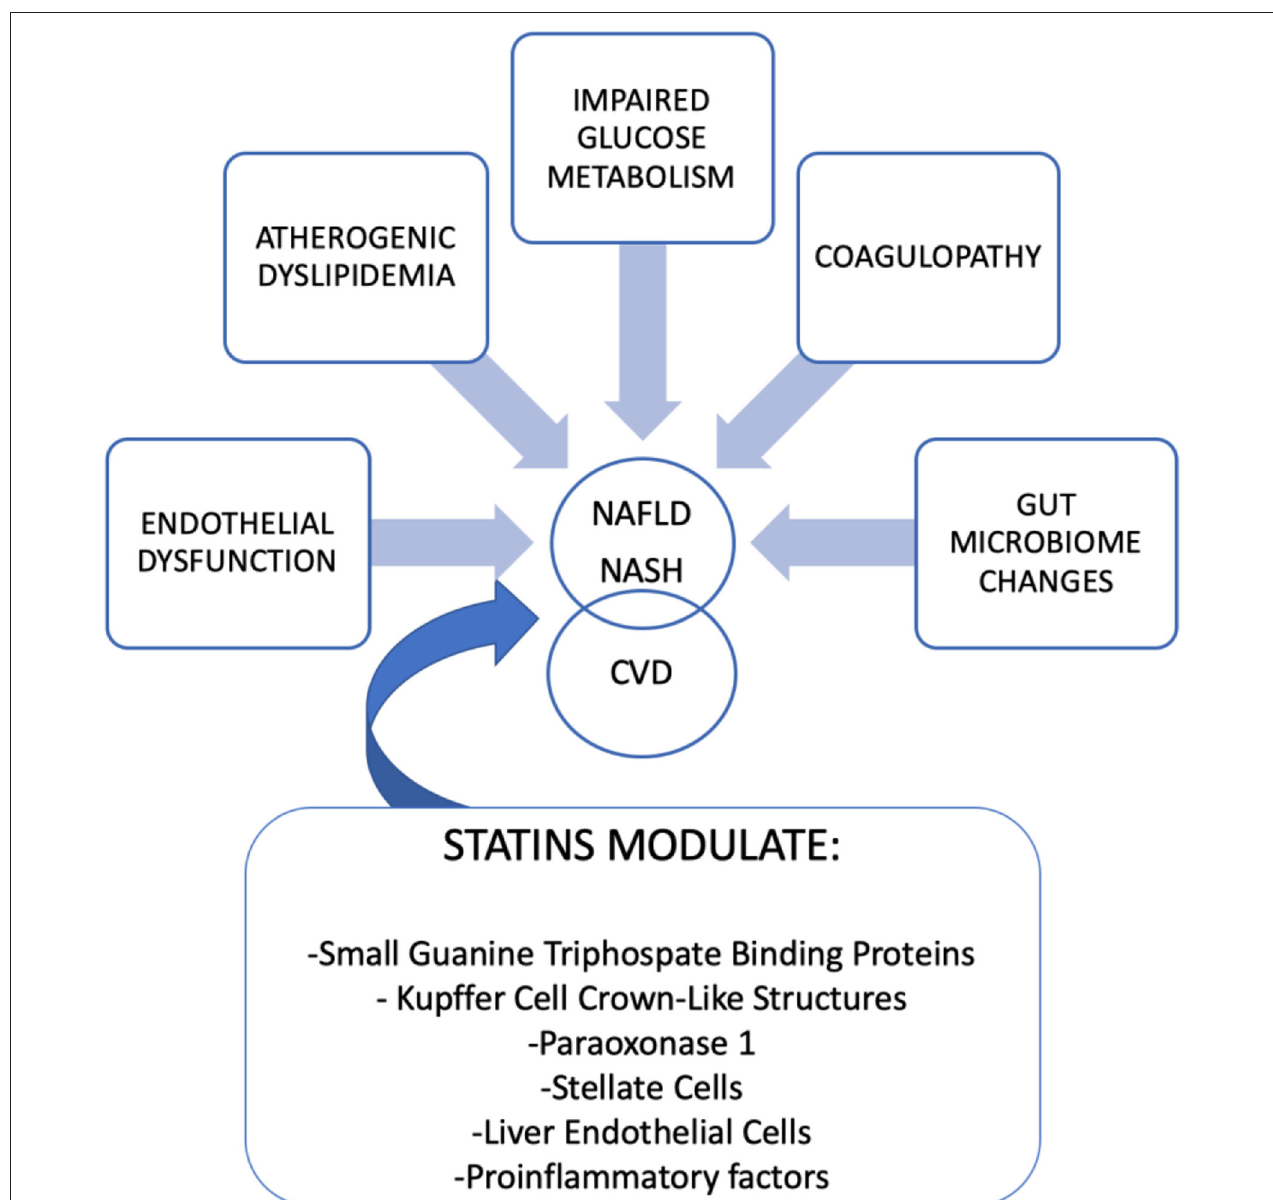
FIGURE 1 | Physiopathology of NAFLD/NASH and link between Cardiovascular Disease (CVD). Mechanism of statins that modulate